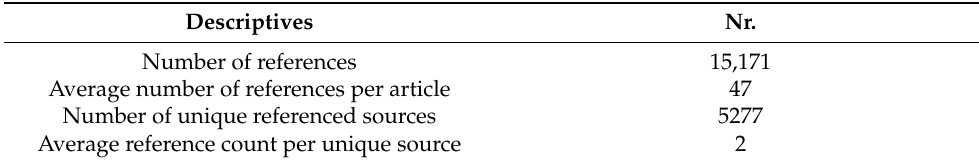
Table 5. Descriptives of the knowledge flow based on